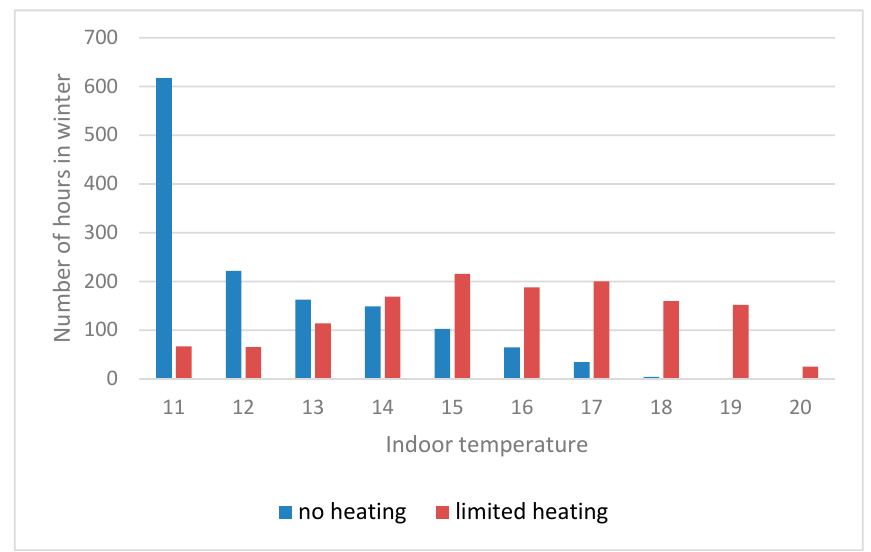
Figure 12. Number of hours and the indoor temperature for a dwelling in building A in winter, with and without heating (limited to actual figures of